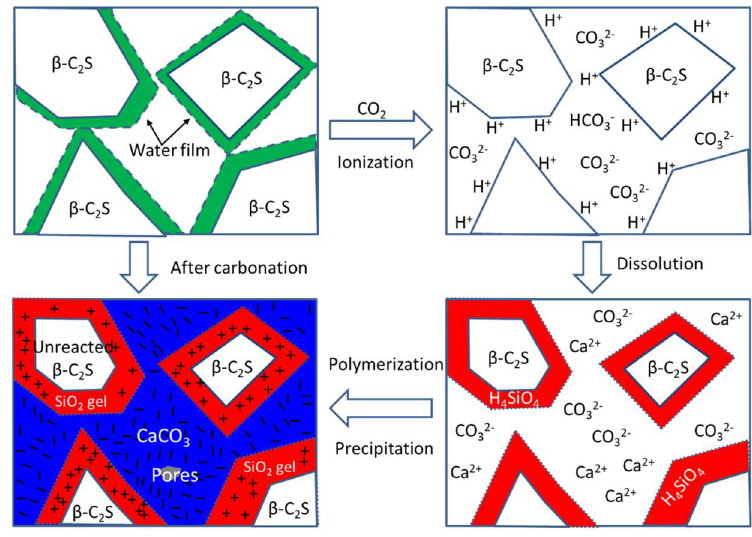
Figure 5. Schematic of carbonation hardening for β-C 2 S.